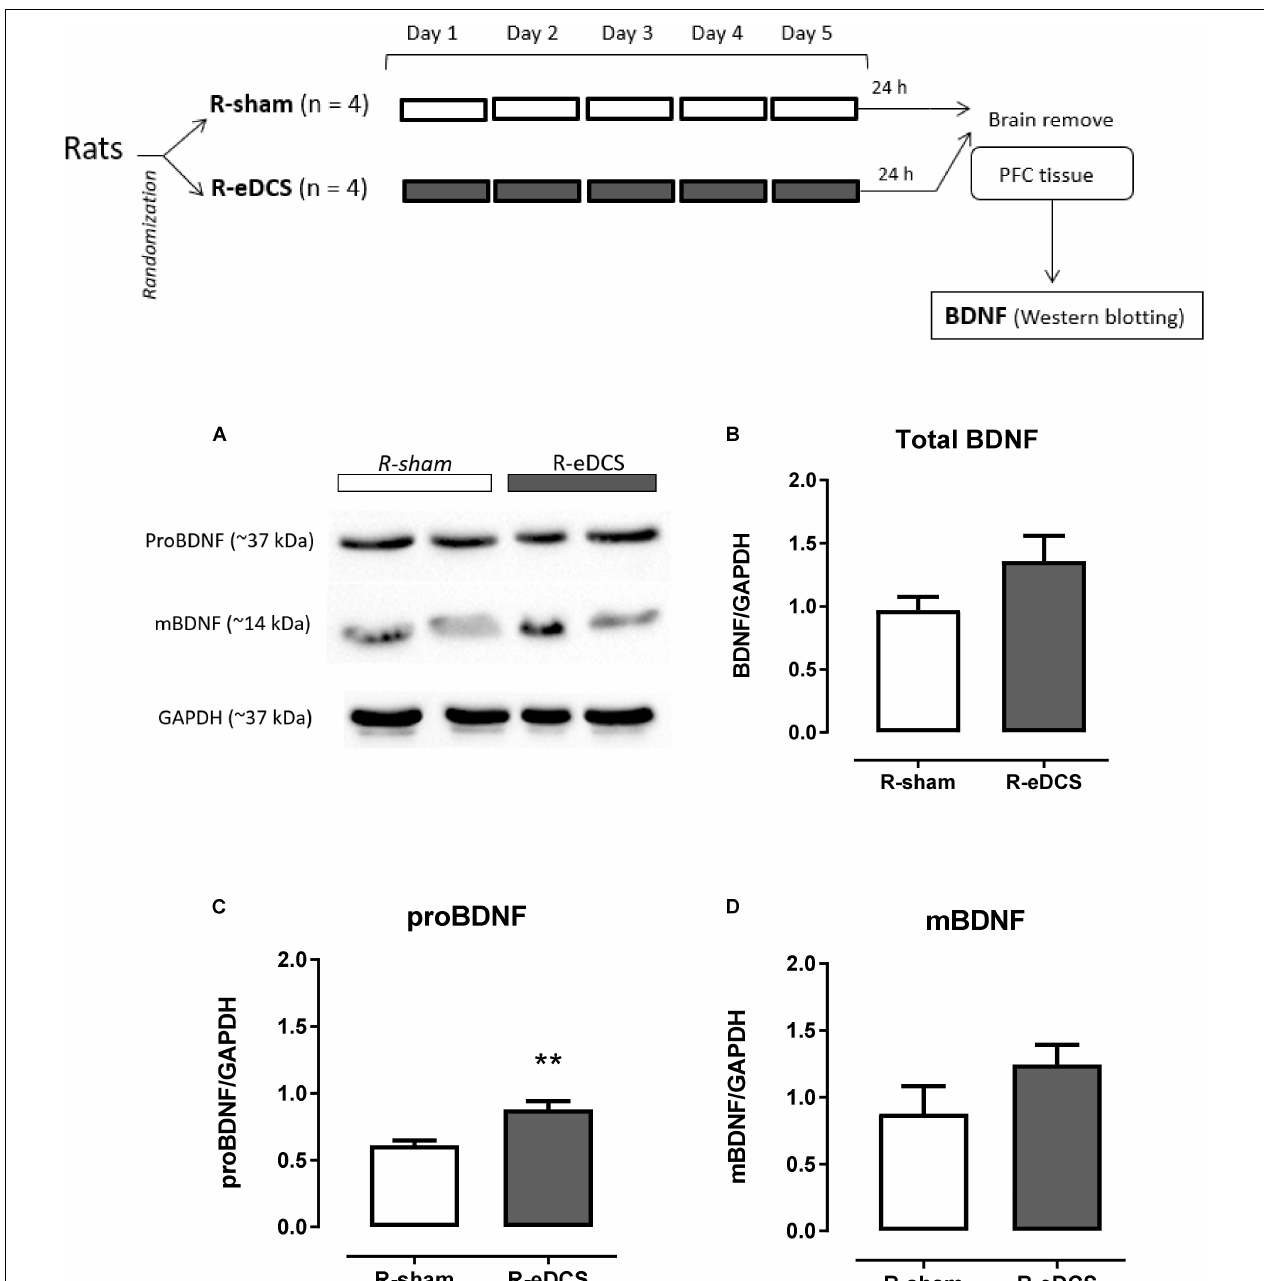
FIGURE 2 | Western blot analysis of brain-derived neurotrophic factor (BDNF) in the prefrontal cortex (PFC) after five (once a day) consecutive sessions of sham (R-sham, n = 4) or epidural direct current stimulation (R-eDCS, n = 4) at 400 µ A current intensity during 11 min through a 5-mm round electrode implanted over the left medial Prefrontal Cortex (mPFC). A diagram of general procedures is shown at the top. (A) Bands of the immunoreactivity related to the migration of the proBDNF and mBDNF shown in two animals – biological replicate – from each group; Densitometry analysis for (B) Total BDNF (intensity of proBDNF plus mBDNF), (C) proBDNF, and (D) mBDNF. Densitometry analyses were normalized to GAPDH and values are presented as the mean ± SEM. ∗∗ p < 0.01 when compared to sham control ( t -test for independent samples). Randomization: animals were distributed in groups by computer-generated randomization